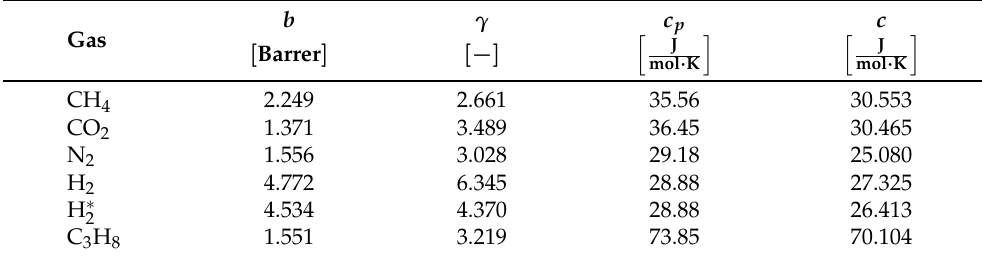
Table 5. Overview of nonlinear regression parameters, isobaric heat capacities at 25 °C [43], and calculated heat capacities based on the polytropic